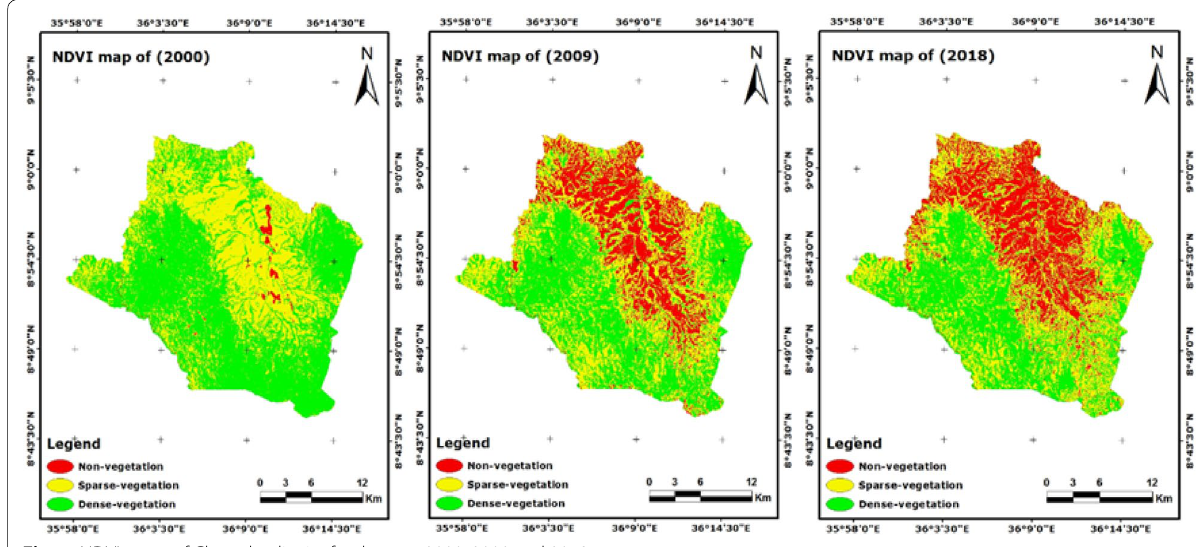
Fig. 5 NDVI maps of Chewaka district for the year 2000, 2009 and 2018